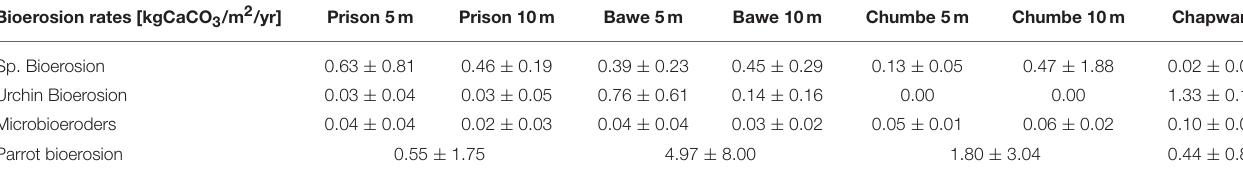
TABLE 3 | Key biogenic groups and microboring bioerosion rates. Bioerosion rates [kgCaCO 3 /m 2 /yr]